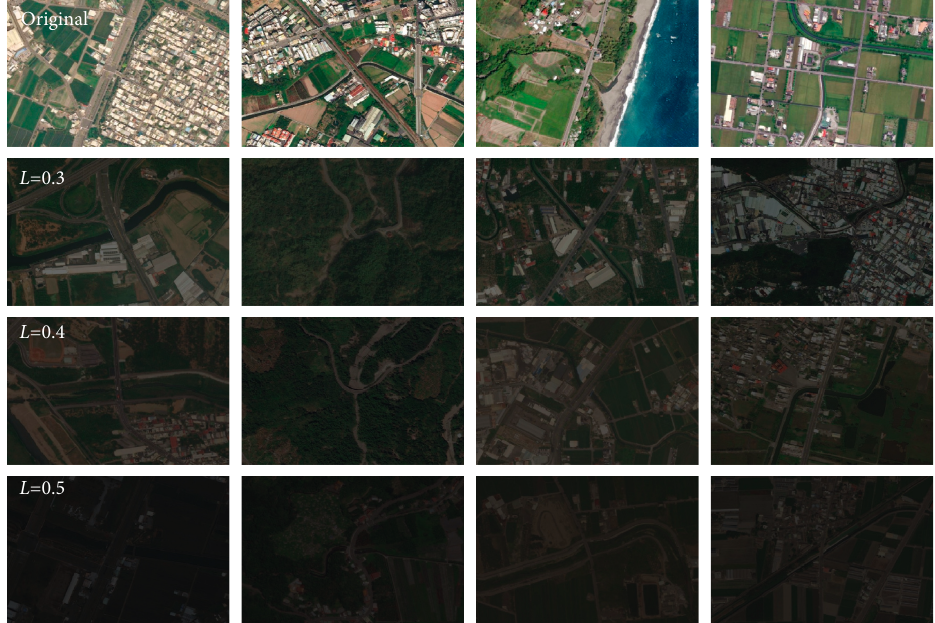
Figure 6: The displays of original images and their low-light versions. From top to bottom: original sharp images and low-light images with L � 0.3, L � 0.4, and L � 0.5, respectively. In particular, L denotes the illumination